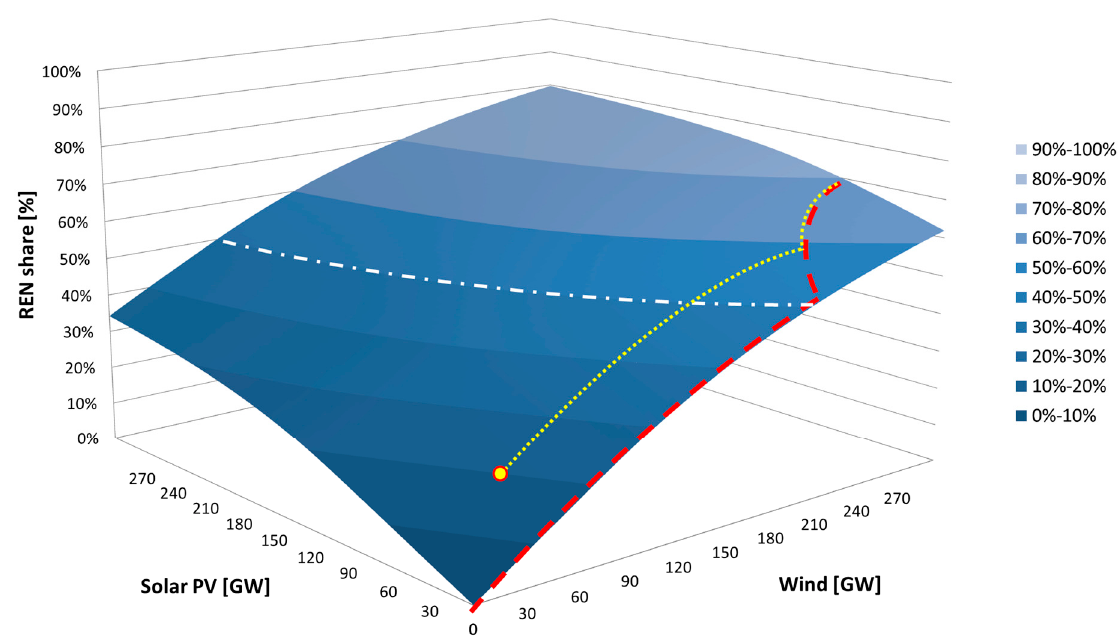
Figure 9. REN share surface plot and efficient pathway for Case BS, including the efficient pathway starting at 0 GW wind and solar PV deployment (dashed line), the efficient pathway starting at the 2017 capacities from wind and solar PV (dotted line), and the 50% REN share marking for various combinations resulting in a 50% REN share (mixed dotted-dashed line).